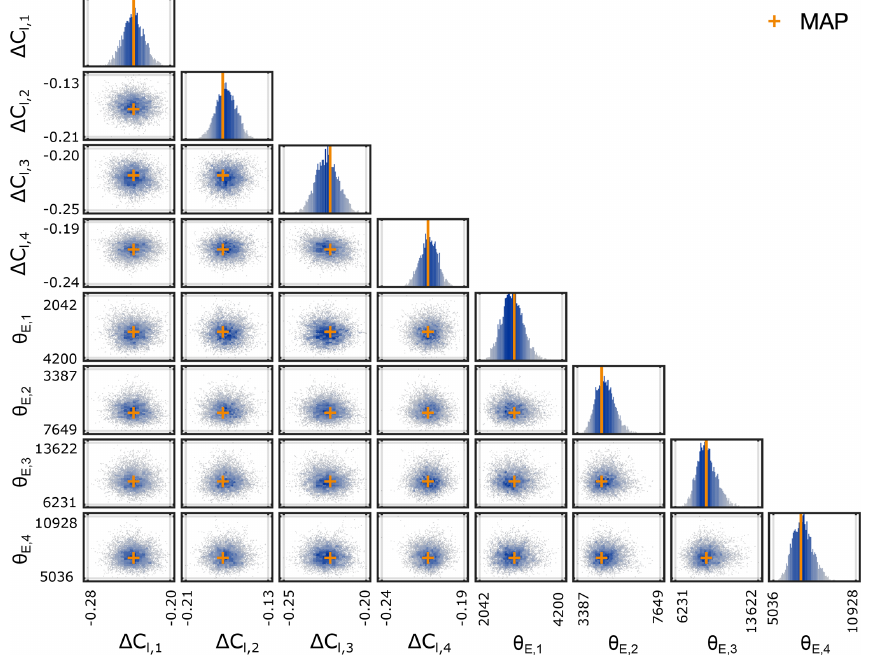
Figure 8. Samples of the posterior distribution of model parameters θ M = ( (cid:49)C l , 1 ...(cid:49)C l , 4 ) and discrepancy parameters θ E = ( θ E, 1 ...θ E, 4 ) for the DANAERO test case with 200 measurements. The orange crosses correspond to the MAP